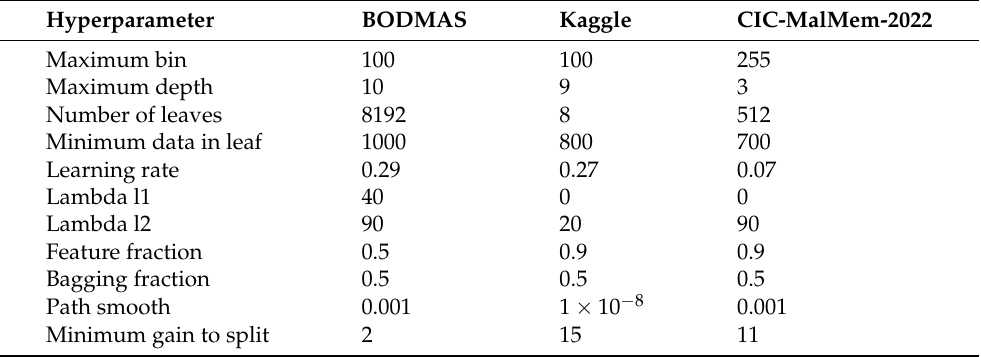
Table 6 contains the list of all final LightGBM hyperparameters used for each malware dataset. Table 6. The final learning parameters of LightGBM used for each dataset after performing ran- dom search .